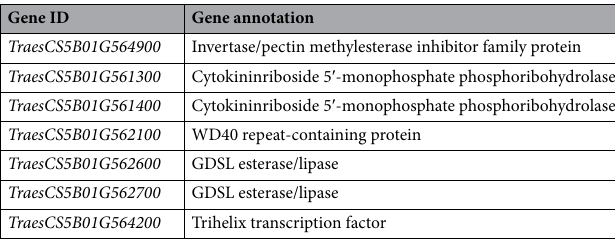
Table 3. Genetic information of additive QTL hotspots in wheat DH population.